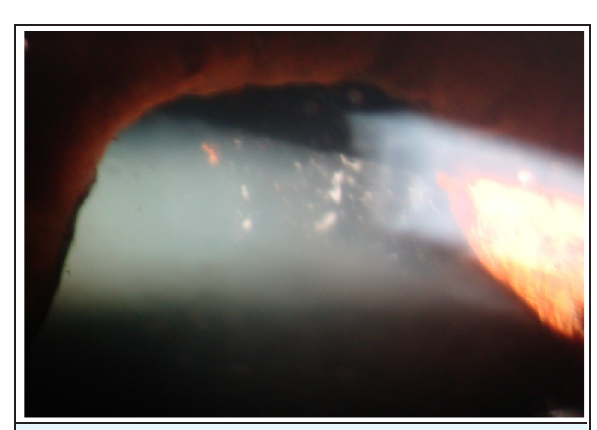
Figure 4. Glaucomfleckon seen in left eye after cor - neal odema